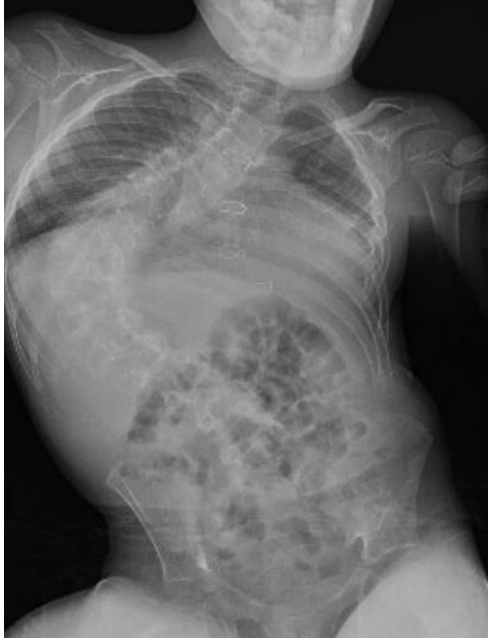
Figure 1. X-ray before surgery with progressive scoliosis, Cobb angle 95°.